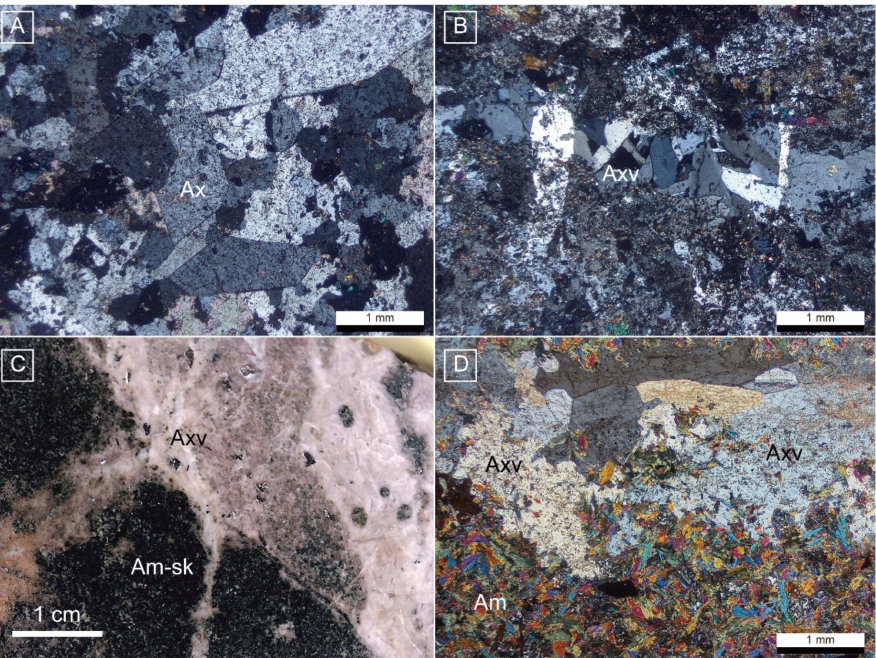
Figure 9. Microphotographs of axinite skarn ( A , B , D ) are under crossed nicols and ( C ) is rock slab. ( A ) Wedge and axe-head shaped axinite (Ax). ( B ) Axinite veinlet (Axv) and small grains of epidotes. ( C , D ) Axinite veinlet (Axv) is injected into the amphibole skarn